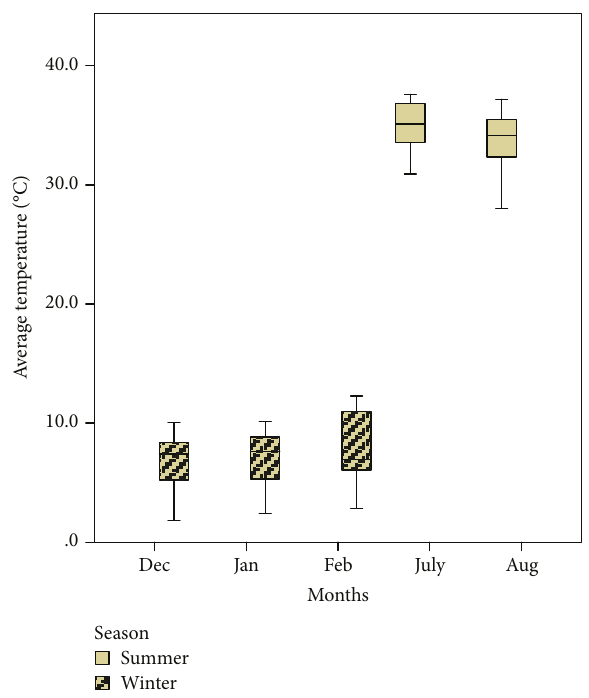
Figure 1: The boxplots of average temperature, during each month of sample taking in summer and winter